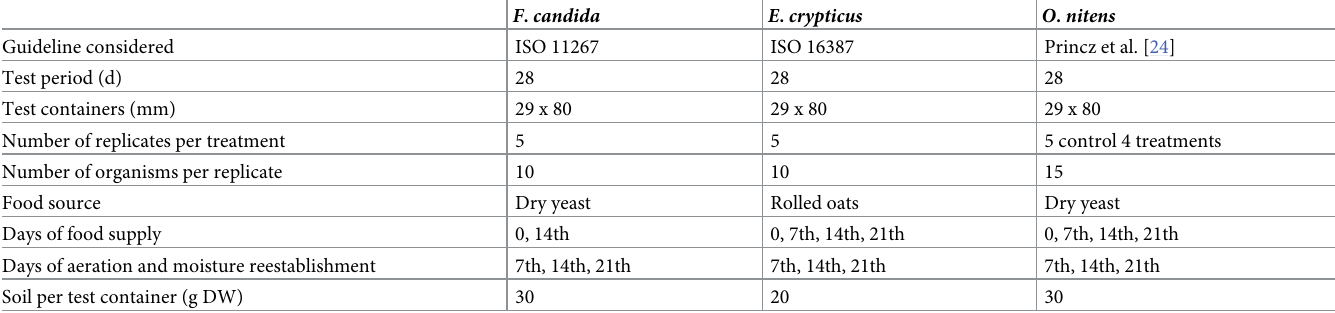
Table 3. Procedures adopted in reproduction tests with Folsomia candida , Enchytraeus crypticus and Oppia nitens . F . candida E . crypticus O .